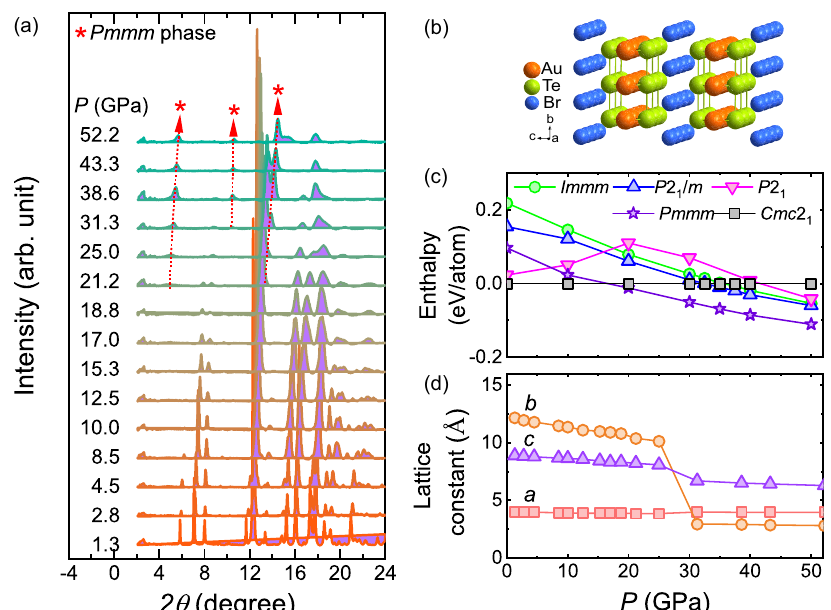
Fig. 3 Pressure evolution of the crystal structure of AuTe 2 Br. a X-ray diffraction 2 θ plot of AuTe 2 Br at room temperature up to 52.2 GPa. The ambient pressure Cmc 2 1 structure persists to ~18.8 GPa, beyond which new diffraction peaks emerge (each marked with a dashed line and asterisk), indicating the emergence of pressure-induced structural phase transition. b Crystal structure of the high-pressure AuTe 2 Br with Pmmm space group. c Enthalpy calculations for several predicted structures. Above 15 GPa, the Pmmm symmetry has the lowest enthalpy. d Pressure dependence of the lattice constants derived from Rietveld re fi